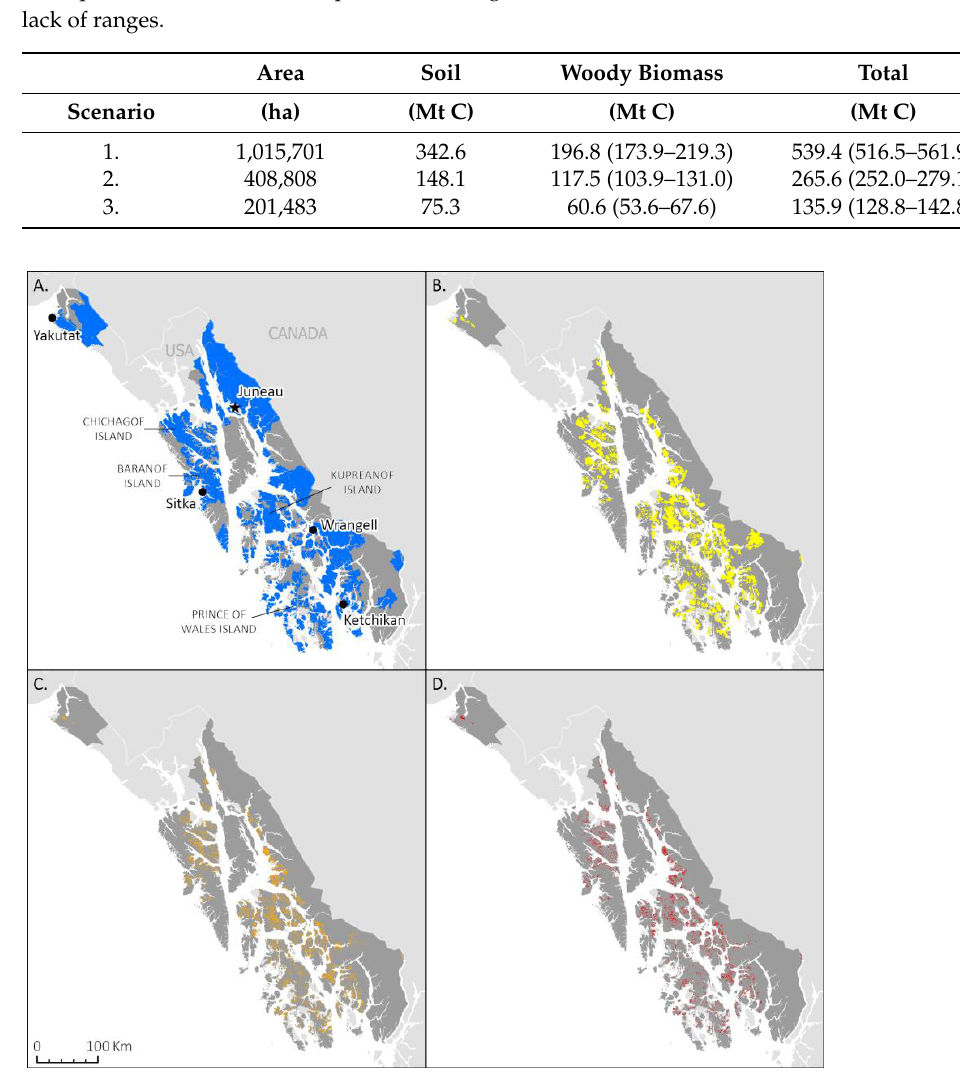
Figure 4. Spatial distribution of inventoried roadless areas based on: ( A ) all roadless areas (blue), ( B ) scenario 1 (yellow), ( C ) scenario 2 (orange), and ( D ) scenario 3 (red). Study area shown in gray. See Section 2.5. for description of scenarios.